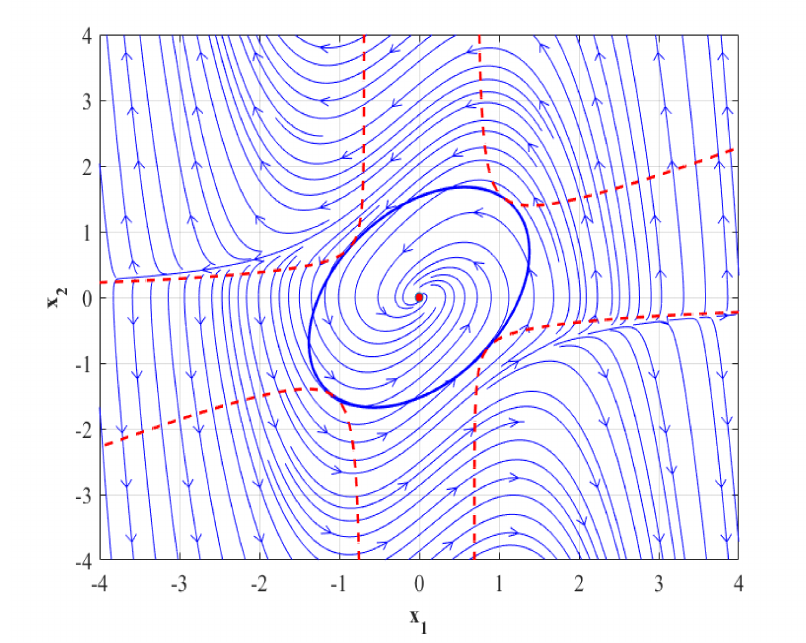
Figure 4. Approximated DA for the Van der Pol model in the CPSO method; the blue ellipsoid characterises the estimated stability domain, the (the boundary of the light blue area) dashed red line · V ( x ) < denotes the region in which